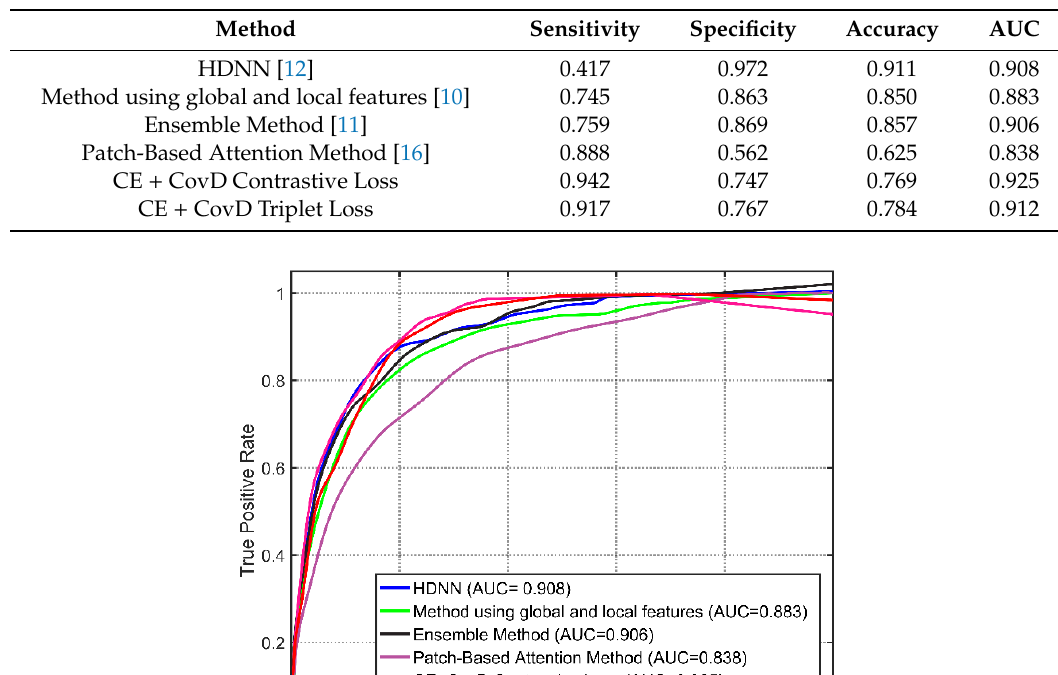
Table 2. Experimental result of our method and the other methods.